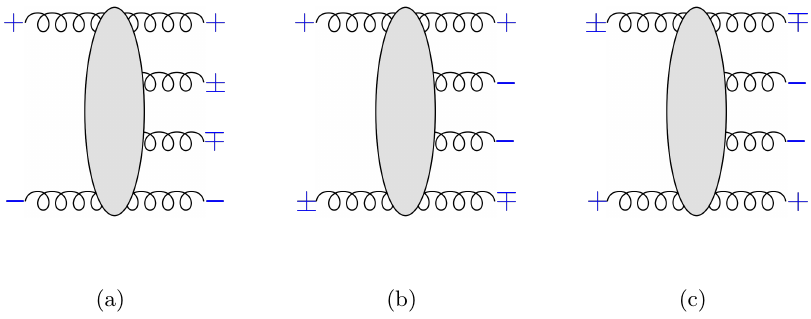
Figure 12 . Six of the NMHV helicity configurations that are power suppressed in the central NMRK limit. The remaining six power-suppressed NMHV configurations can be obtained by flipping all helicities. The labelling of the gluons follows figure